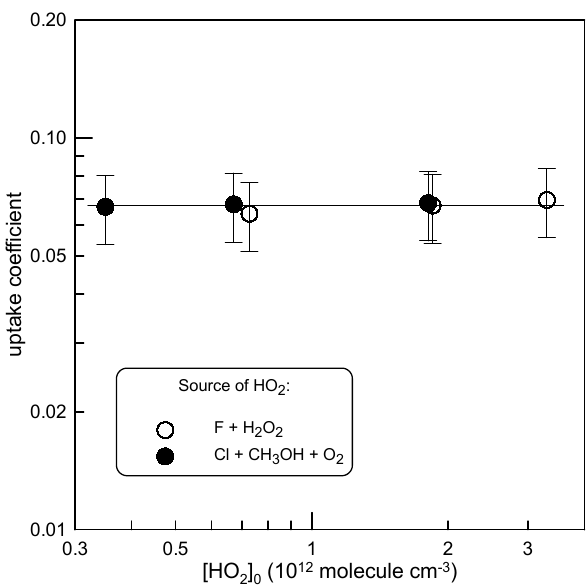
Fig. 5. Uptake coefficients as function of the initial concentration of HO 2 : T = 300K, P = 1Torr, dry conditions, sample mass = (1.2– 1.4)mgcm − 1